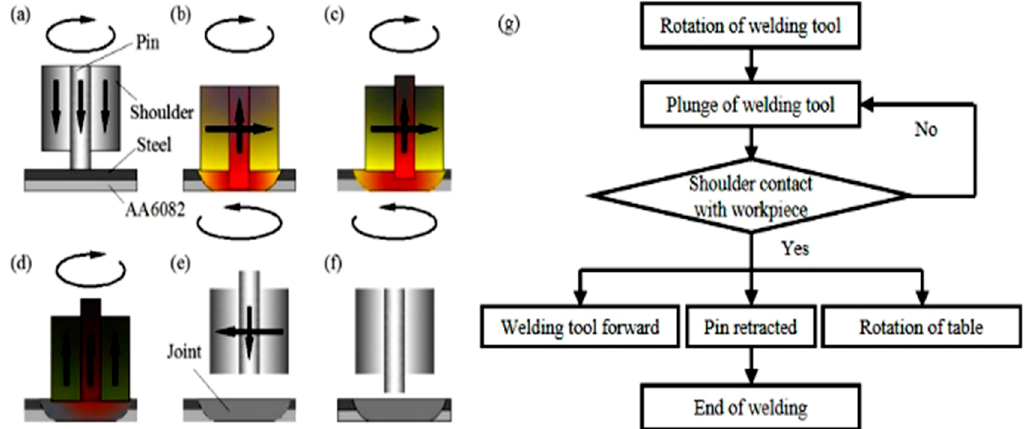
Figure 1. Schematic diagram and flow chart of dissimilar Al/steel keyhole-free FSSW process. FSSW), ( a ) welding initial stage, ( b ) warming-up stage, ( c ) welding stage, ( d ) welding end stage, ( e ) cooling stage, (f) initializing stage, ( g ) the flow chart of the keyhole-free FSSW process. Table 2. Welding parameters of dissimilar Al / steel keyhole-free FSSW